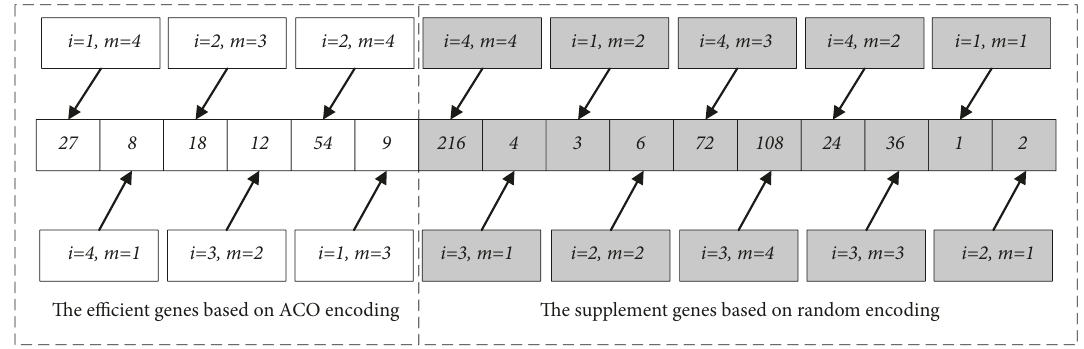
Figure 6: The illustration of